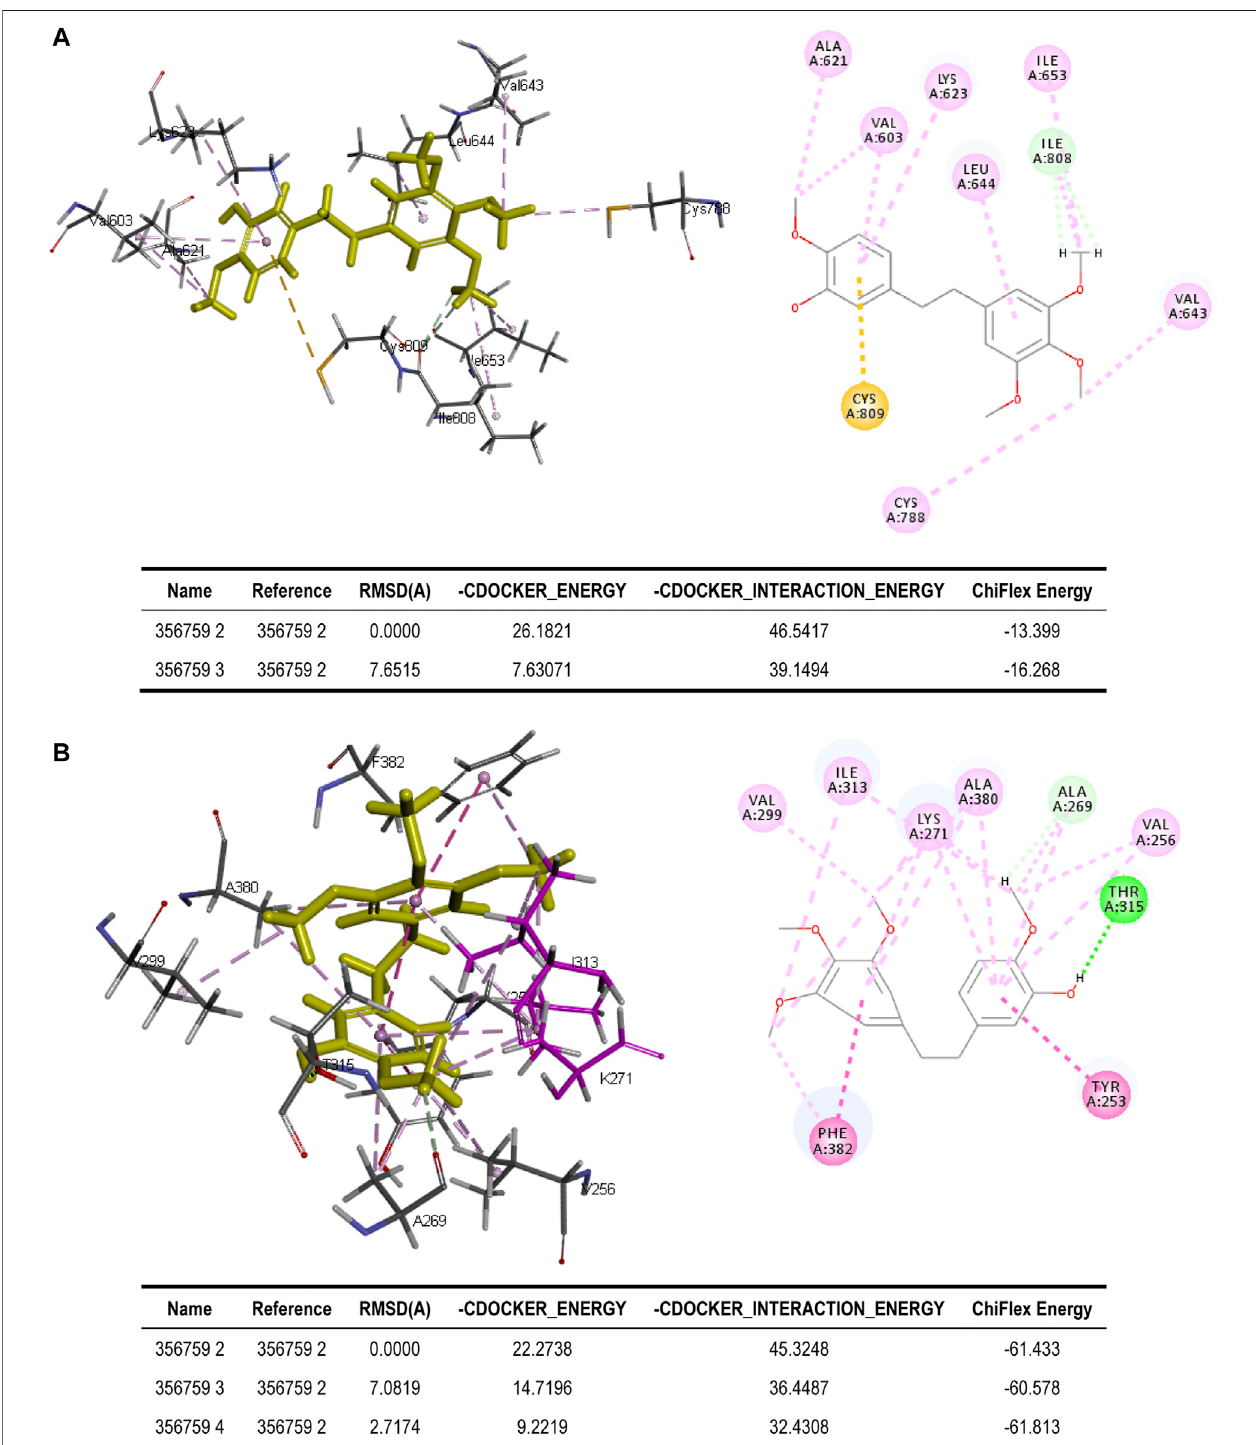
FIGURE 5 | Binding of erianin with (A) KIT and (B) ABL1 by molecular docking. Erianin exhibits high binding af fi nity to KIT protein via sites of Ala621, Val603, Lys623, Leu644, Ile653, Ile808, Val643, Cys788, and Cys809, and to ABL1 protein via sites of Val299, Ile313, Lys271, Ala380, Ala269, Val256, Thr315, Tyr253, and